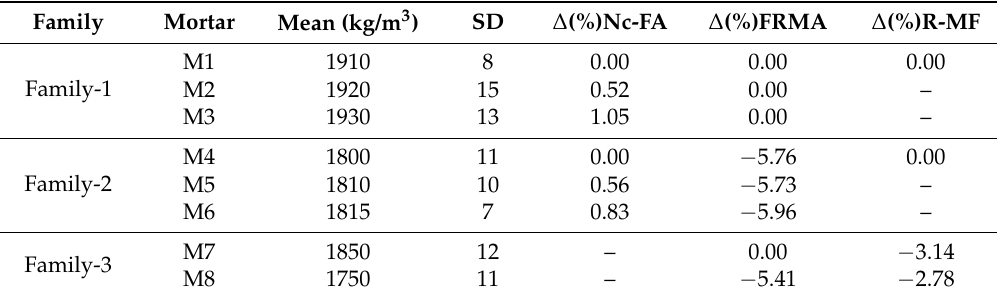
Table 9. Bulk density of hardened mortar at 28